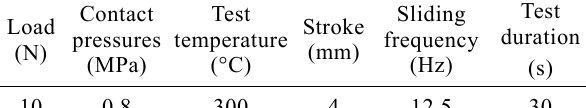
Table 2 Test parameters used in the tribological tests.